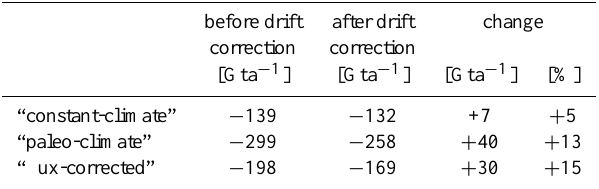
Table 2. Simulated mass loss trends before and after drift removal for the three